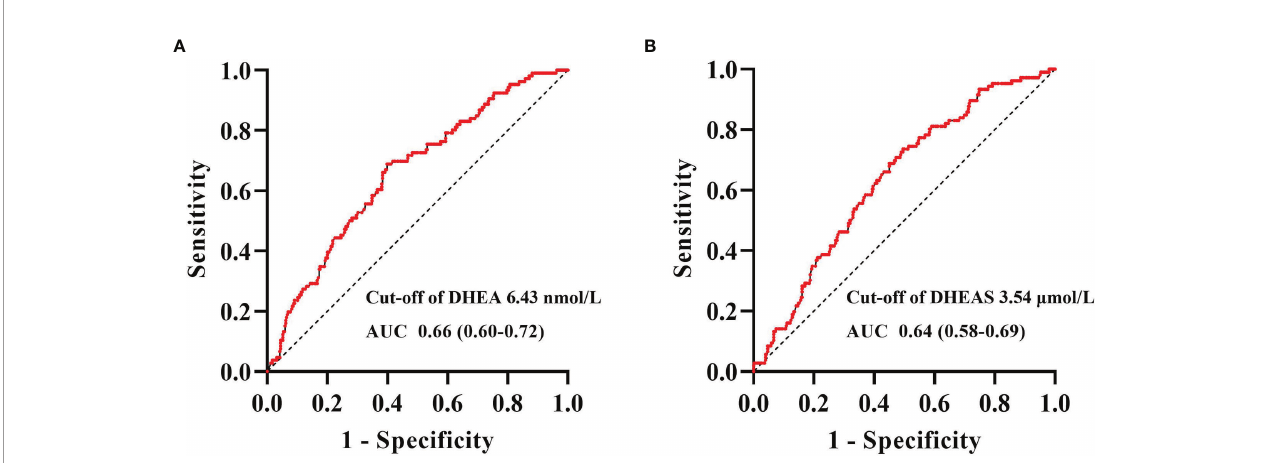
FIGURE 5 | Receiver operating characteristic (ROC) curve analysis of dehydroepiandrosterone (DHEA) and dehydroepiandrosterone sulfate (DHEAS) to recognize coronary heart disease (CHD) in men with type 2 diabetes mellitus. ROC curve analysis revealed that the areas under the curve (AUCs) for DHEA (A) and DHEAS (B) were 0.66 (95% CI = 0.60 – 0.72) and 0.64 (95% CI = 0.58 – 0.69), respectively. The optimal cutoff values, with the best trade-off between sensitivity and speci fi city, were 6.43 nmol/L for DHEA and 3.54 m mol/L for